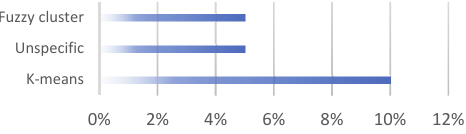
Fig. 11. Comparison of the clustering